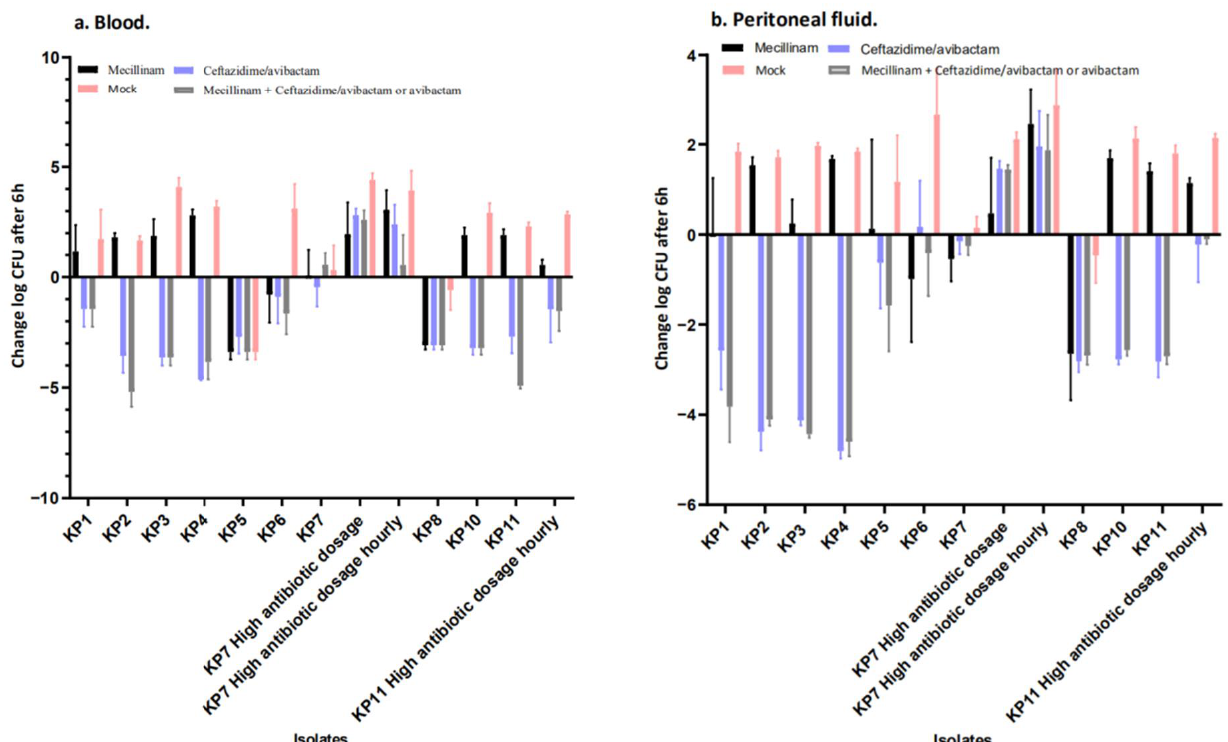
Figure 2. ( a,b ) . In vivo results of treatment regimens for the included K. pneumoniae isolates. The standard doses were 100 mg kg −1 ceftazidime/avibactam alone, 50 mg kg −1 mecillinam alone, 100 mg kg −1 ceftazidime/avibactam and 50 mg kg −1 mecillinam together or saline administered s.c. at t = 1 h and t = 3 h. For strain KP7, two higher dose regimens were used, i.e., 200 mg kg −1 ceftazidime/avi- bactam alone, 200 mg kg −1 mecillinam alone, 200 mg kg −1 ceftazidime/avibactam and 200 mg kg −1 mecillinam together or saline administered at t = 1 h and t = 3 h (marked in the figure with “high antibiotic dosage”), and the same higher dose administ ered hourly, i.e., t = 1 h, t = 2 h, t = 3 h and t = 4 h (marked in the figure with “high antibiotic dosage hourly”). This latter dose was also used for strain KP11. Data are presented as changes in log CFU mL −1 in either blood or peritoneal fluid t = 5 h. The figure compares CFU counts in peritoneal fluid and blood at the end of antibiotic treatment to mock-treated controls at the same time points. Thus, the figure compares all CFU counts at the end of the treatment period with animals sacrificed at 0 h, i.e., immediately before antibiotic treat- ment was initiated. The result of this new depiction is that reductions in CFU counts caused by antibiotic treatment appeared smaller as the difference was calculated relative to controls at baseline with lower counts instead of compared to 5 h mock- treated controls. The “mock” group depicted the increase in bacterial burden in mock-treated animals during the treatment period.